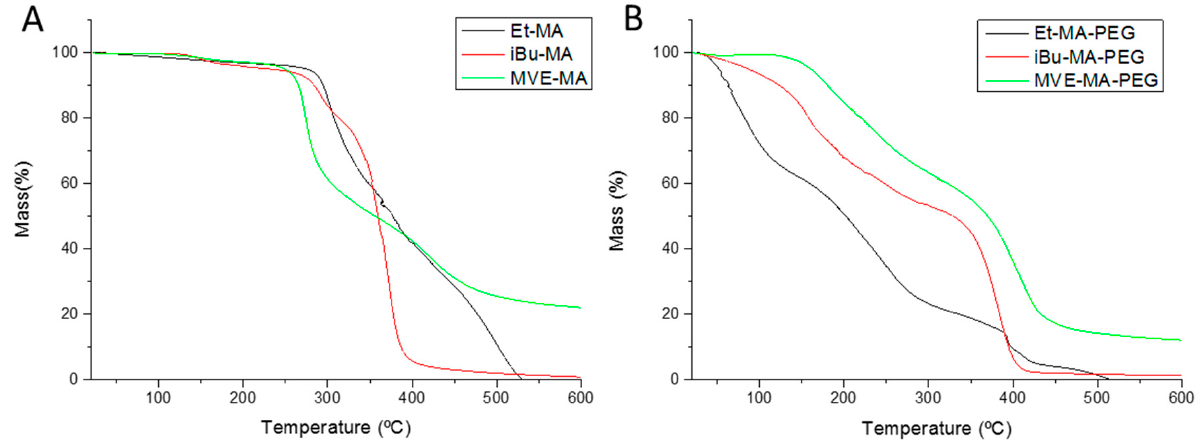
Figure 4. Thermal stability of the copolymer ( A ) and hydrogels ( B ).